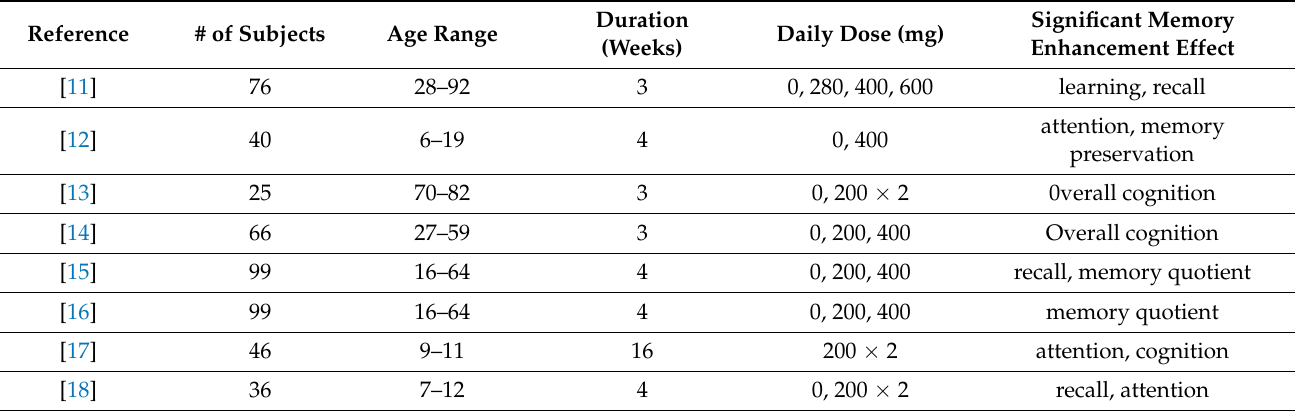
Table 1. Silk Fibroin Enzyme Hydrolysate Clinical Human